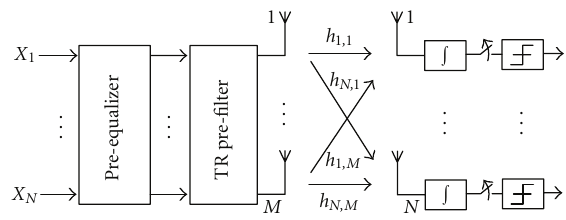
Figure 1: Block diagram of an SM-MIMO UWB